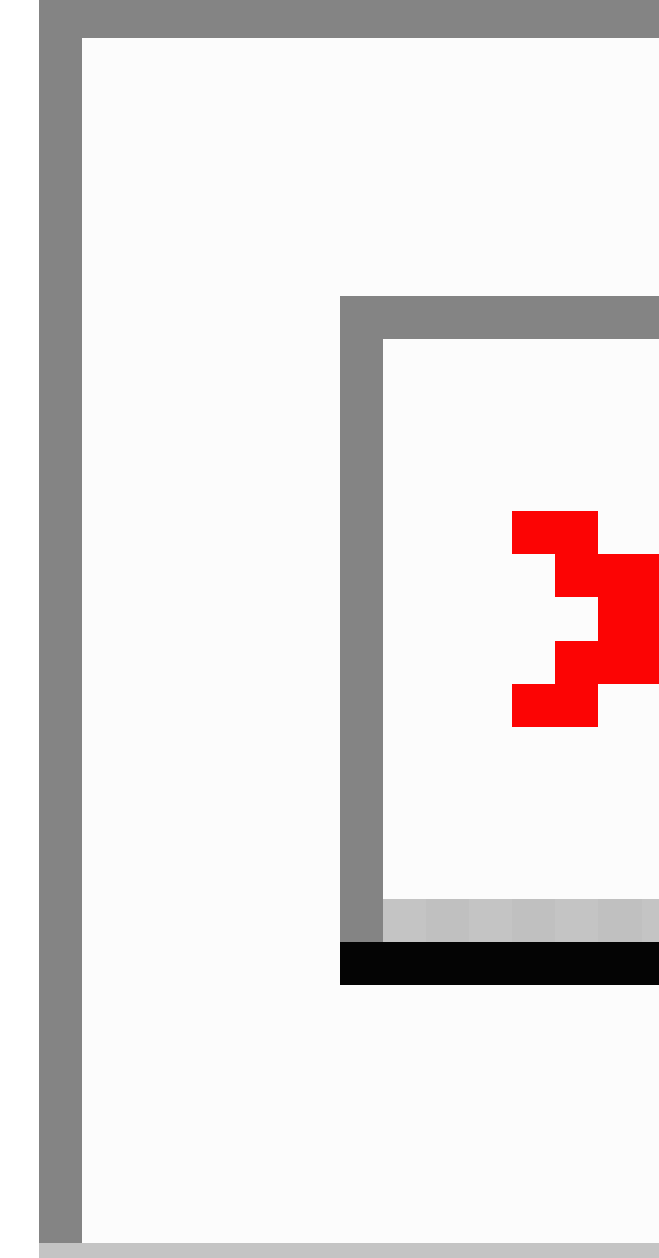
Figure 2. Frequency of positive and negative symptoms for 10